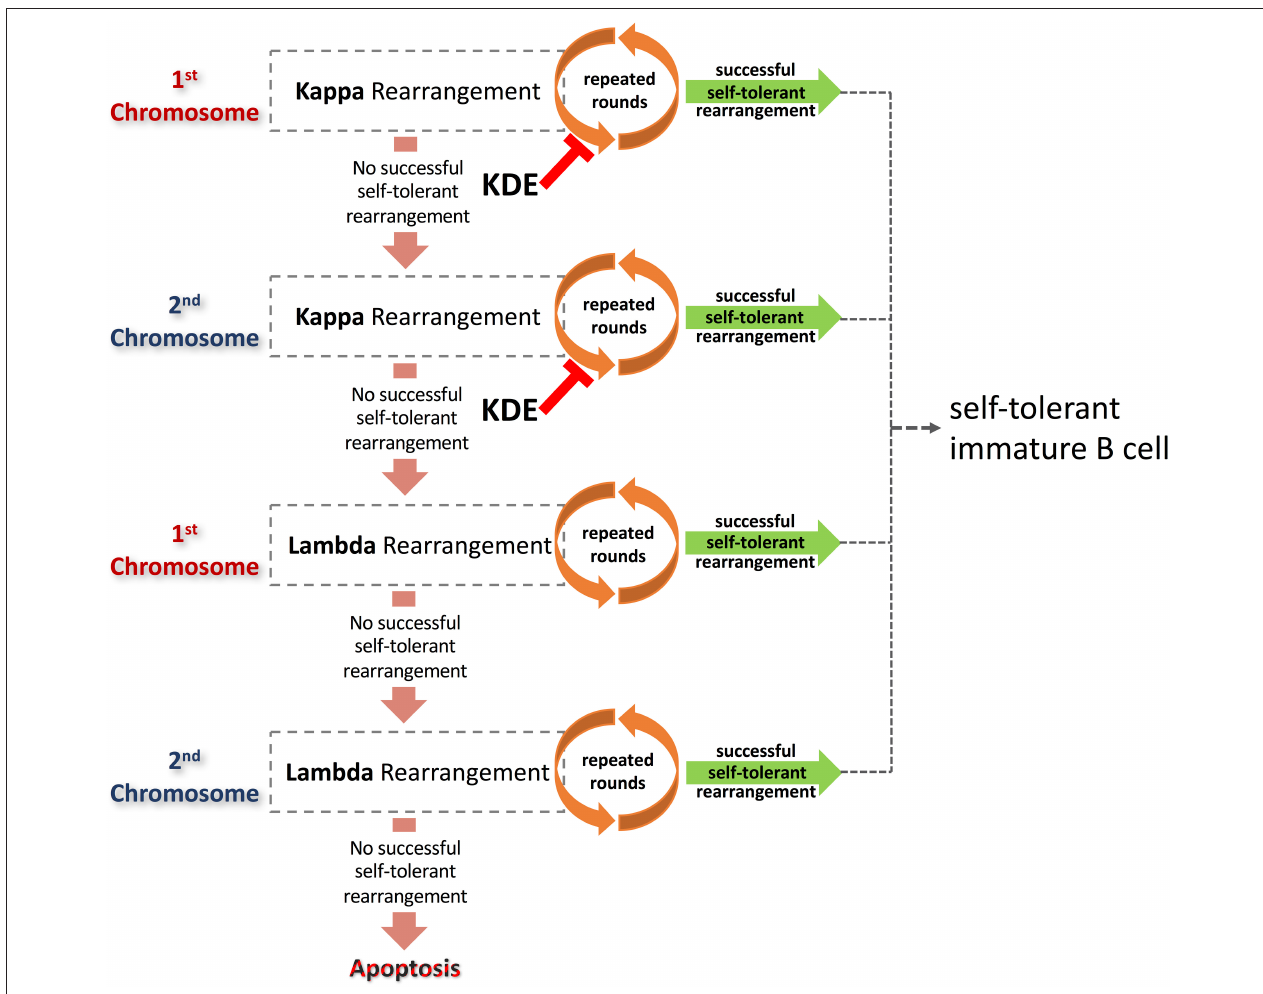
FIGURE 3 | Light chain rearrangements provide multiple pathways to the production of self-tolerant B cells. Alternative pathways are a consequence of rearrangements of the light chain loci that result in non-productive or auto-reactive BCR. Beginning with rearrangements of the κ locus on the first selected chromosome, a succession of light chains can be paired with an existing heavy chain that is already expressed on the surface of the pre-B cell. Each resulting BCR is assessed for affinity to self-antigen. Cells expressing autoreactive antibodies can be rescued via further rounds of receptor editing. If repeated rounds of rearrangements of a locus fail to generate a functional, self-tolerant antibody, and the possibilities of rearrangement are exhausted, the process may continue on other chromosomes. Rounds of κ rearrangement may be prematurely curtailed by the action of the kappa deleting element. B cells unable to generate self-tolerant antibodies despite multiple rounds of receptor editing will ultimately be deleted or rendered anergic. In contrast, B cells that generate successful light chain rearrangements that result in self-tolerant antibodies will go on to develop further into immature B